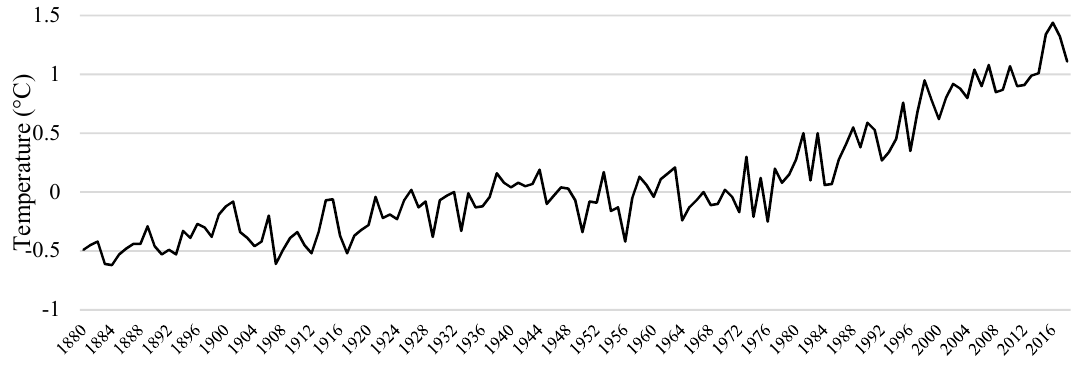
Figure 1. Global land temperature anomalies 1880–2018 [16].